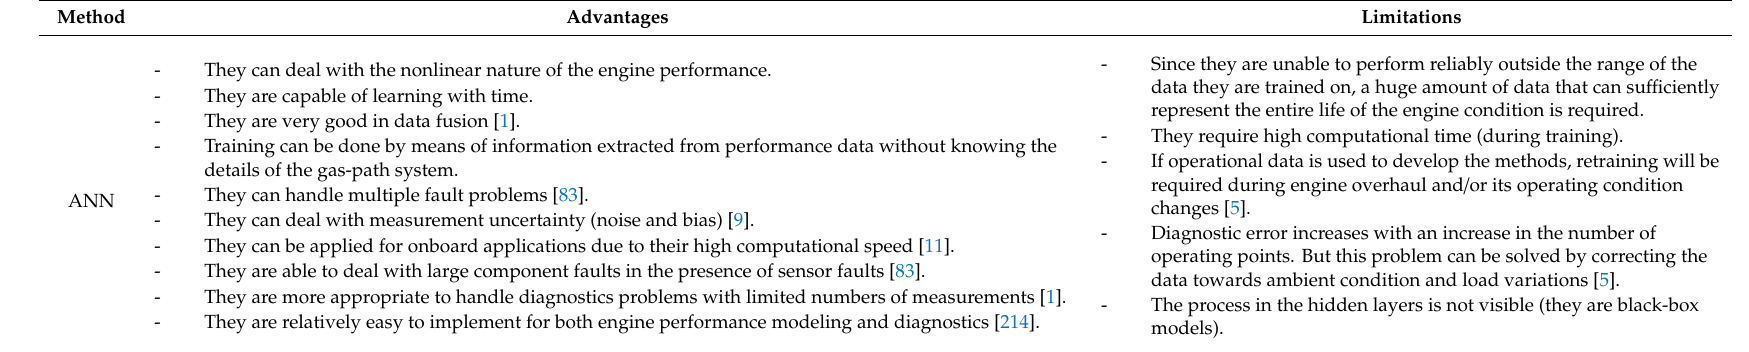
Table 5. Advantages and limitations of AI-based methods regarding GT